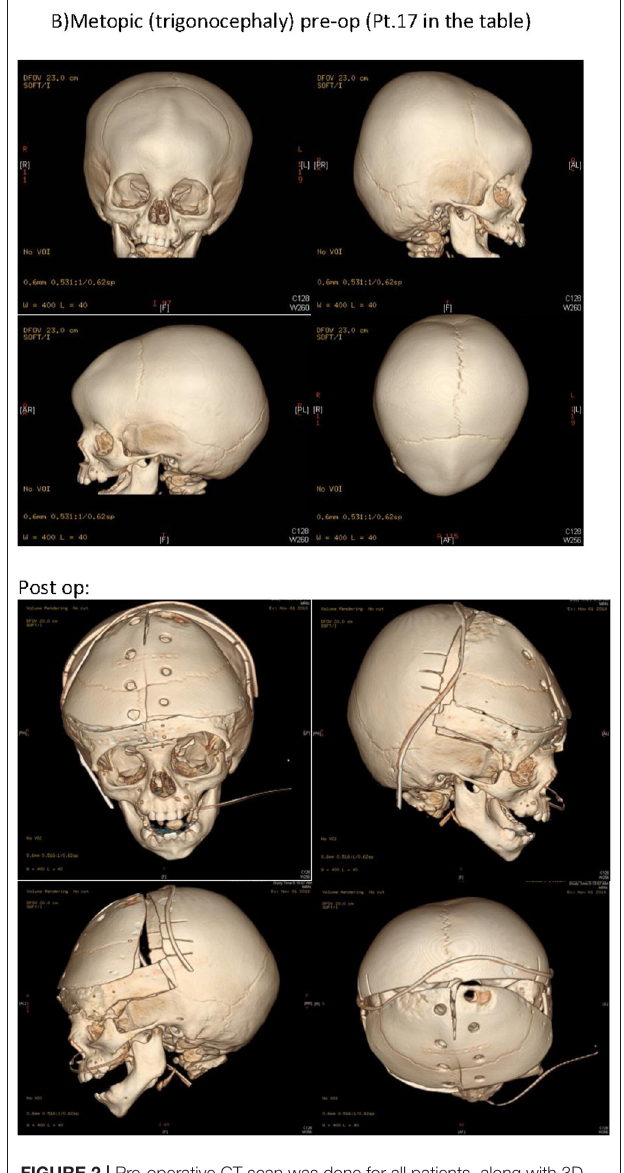
FIGURE 2 | Pre-operative CT scan was done for all patients, along with 3D printed models to aid in patient explanation and decision making. Aperts: pre-op and post-op. CT (Pt.4 in the Table 1 ). B) Metopic (trigonocephaly) pre-op and post-op CT (Pt.17 in the Table 1 ).